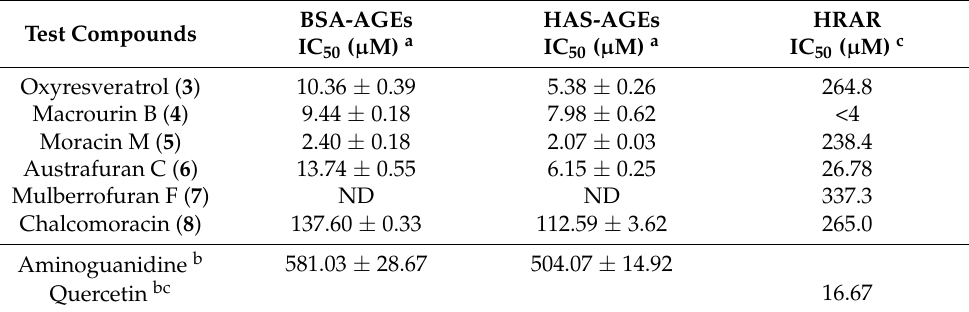
Table 4. Inhibitory activities of AGEs formation and HRAR of isolated compounds of EtOAc fraction from Morus bombycis